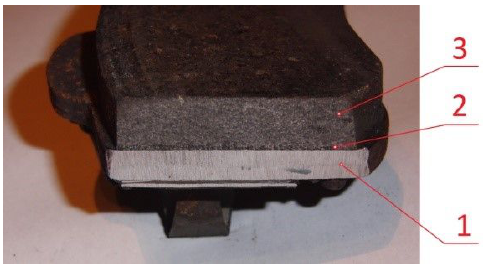
Figure 2: Key brake pad components: 1- back plate, 2- underlayer, 3- friction